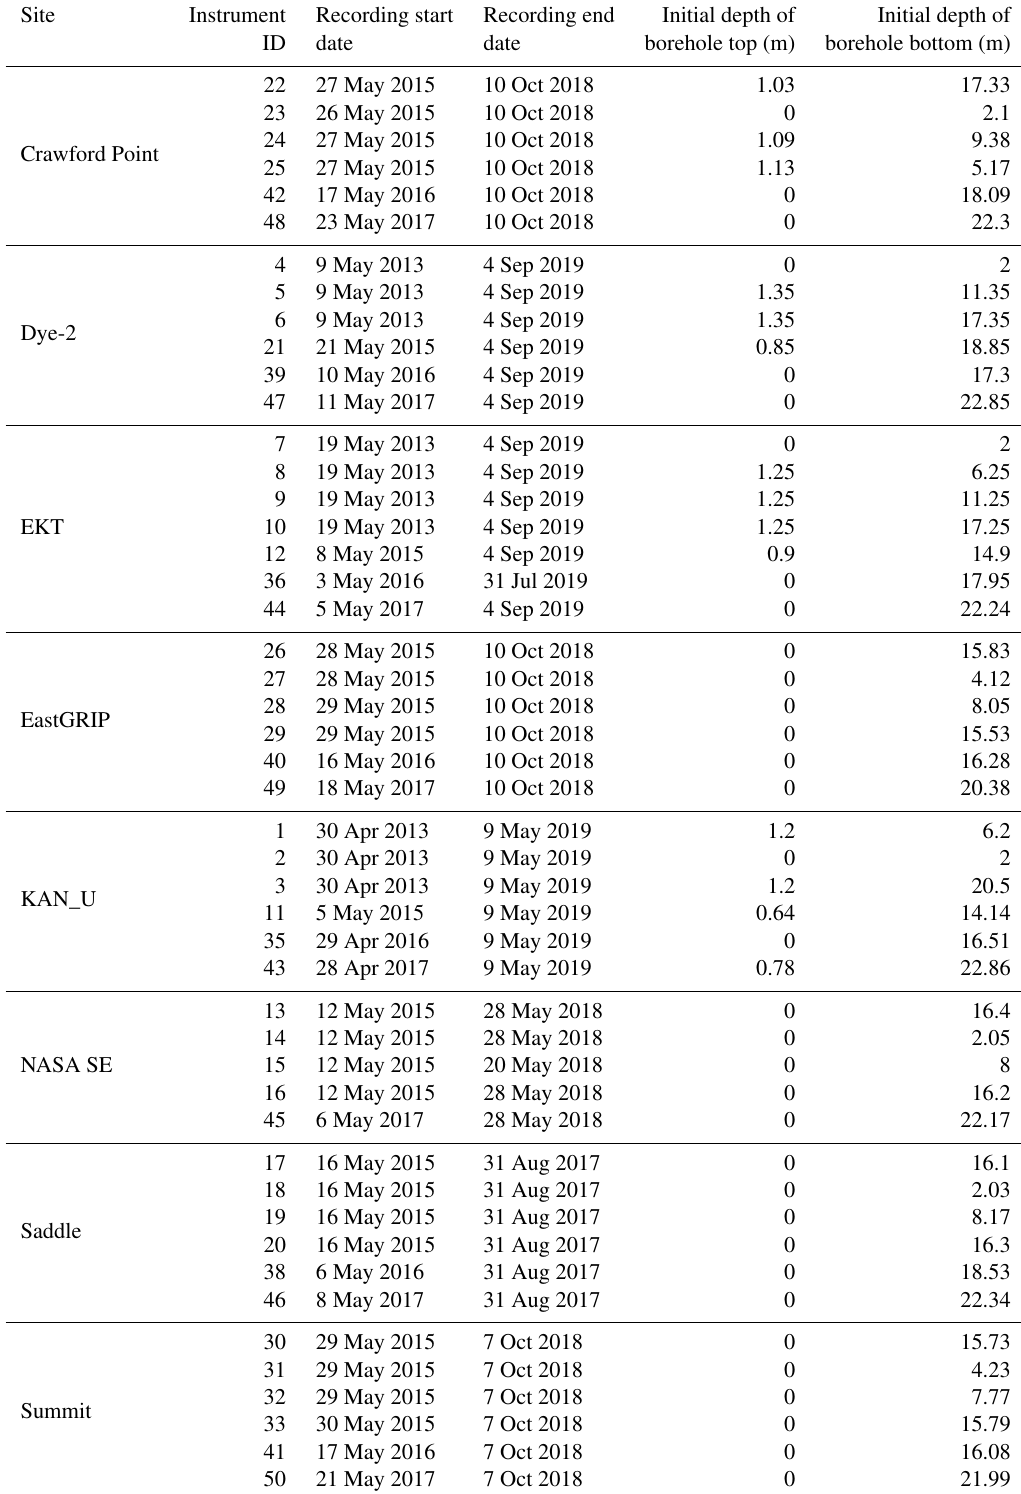
Table 2. FirnCover instrument